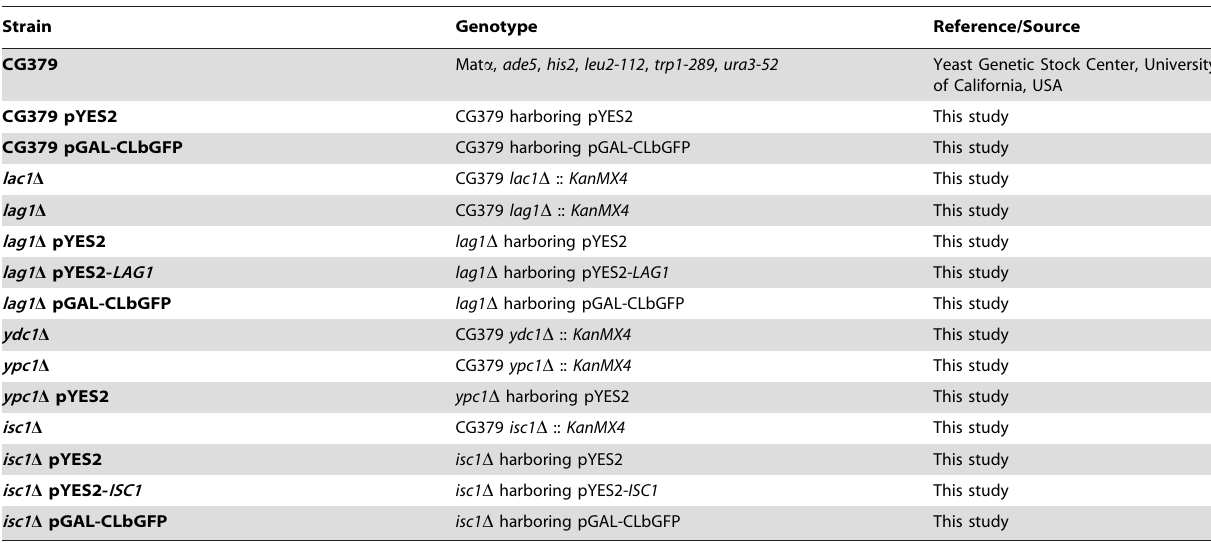
Table 1. List of S. cerevisiae strains used in this study.